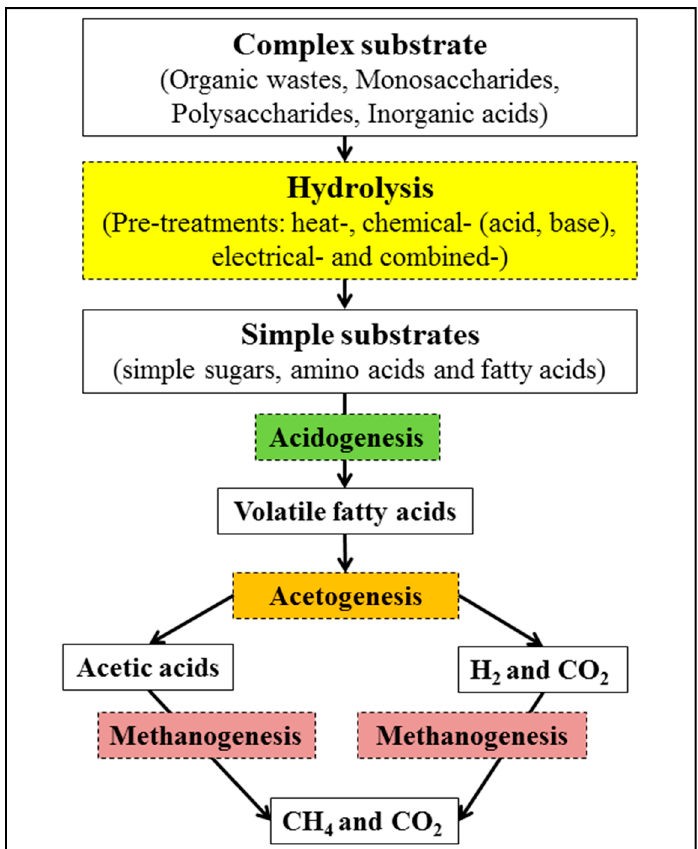
Figure 1. Anaerobic digestion of complex substrates using biochemical conversion pathways.